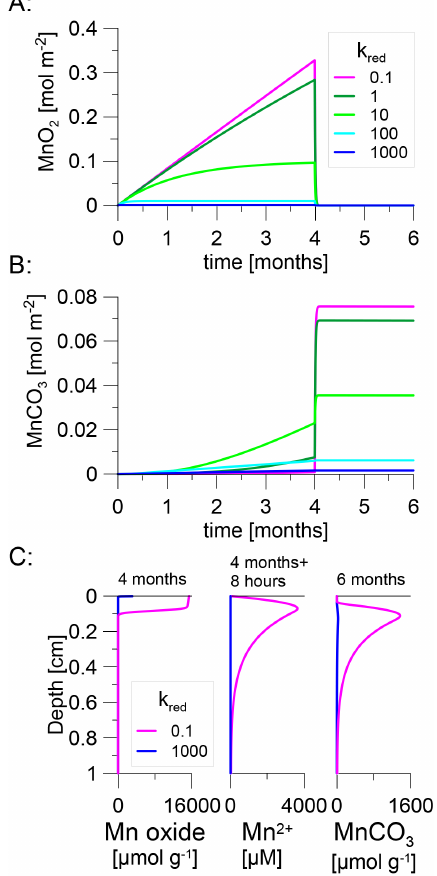
Figure 6. (a) Integrated amount of Mn oxide and (b) integrated amount of Mn carbonate in the upper cm of the sediment (in molm − 2 ) for the simulation, with k red being equal to either 0.1, 1, 10, 100 or 1000yr − 1 for the first 4 months and equal to 1000yr − 1 for the last 2 months, as described in the text. (c) Depth profiles of Mn oxide (after 4 months, end of the oxic phase), dissolved Mn (af- ter 4 months and 8h, directly after the start of the anoxic phase) and MnCO 3 (after 6 months) as calculated with the model in the same scenarios as (a) and (b)